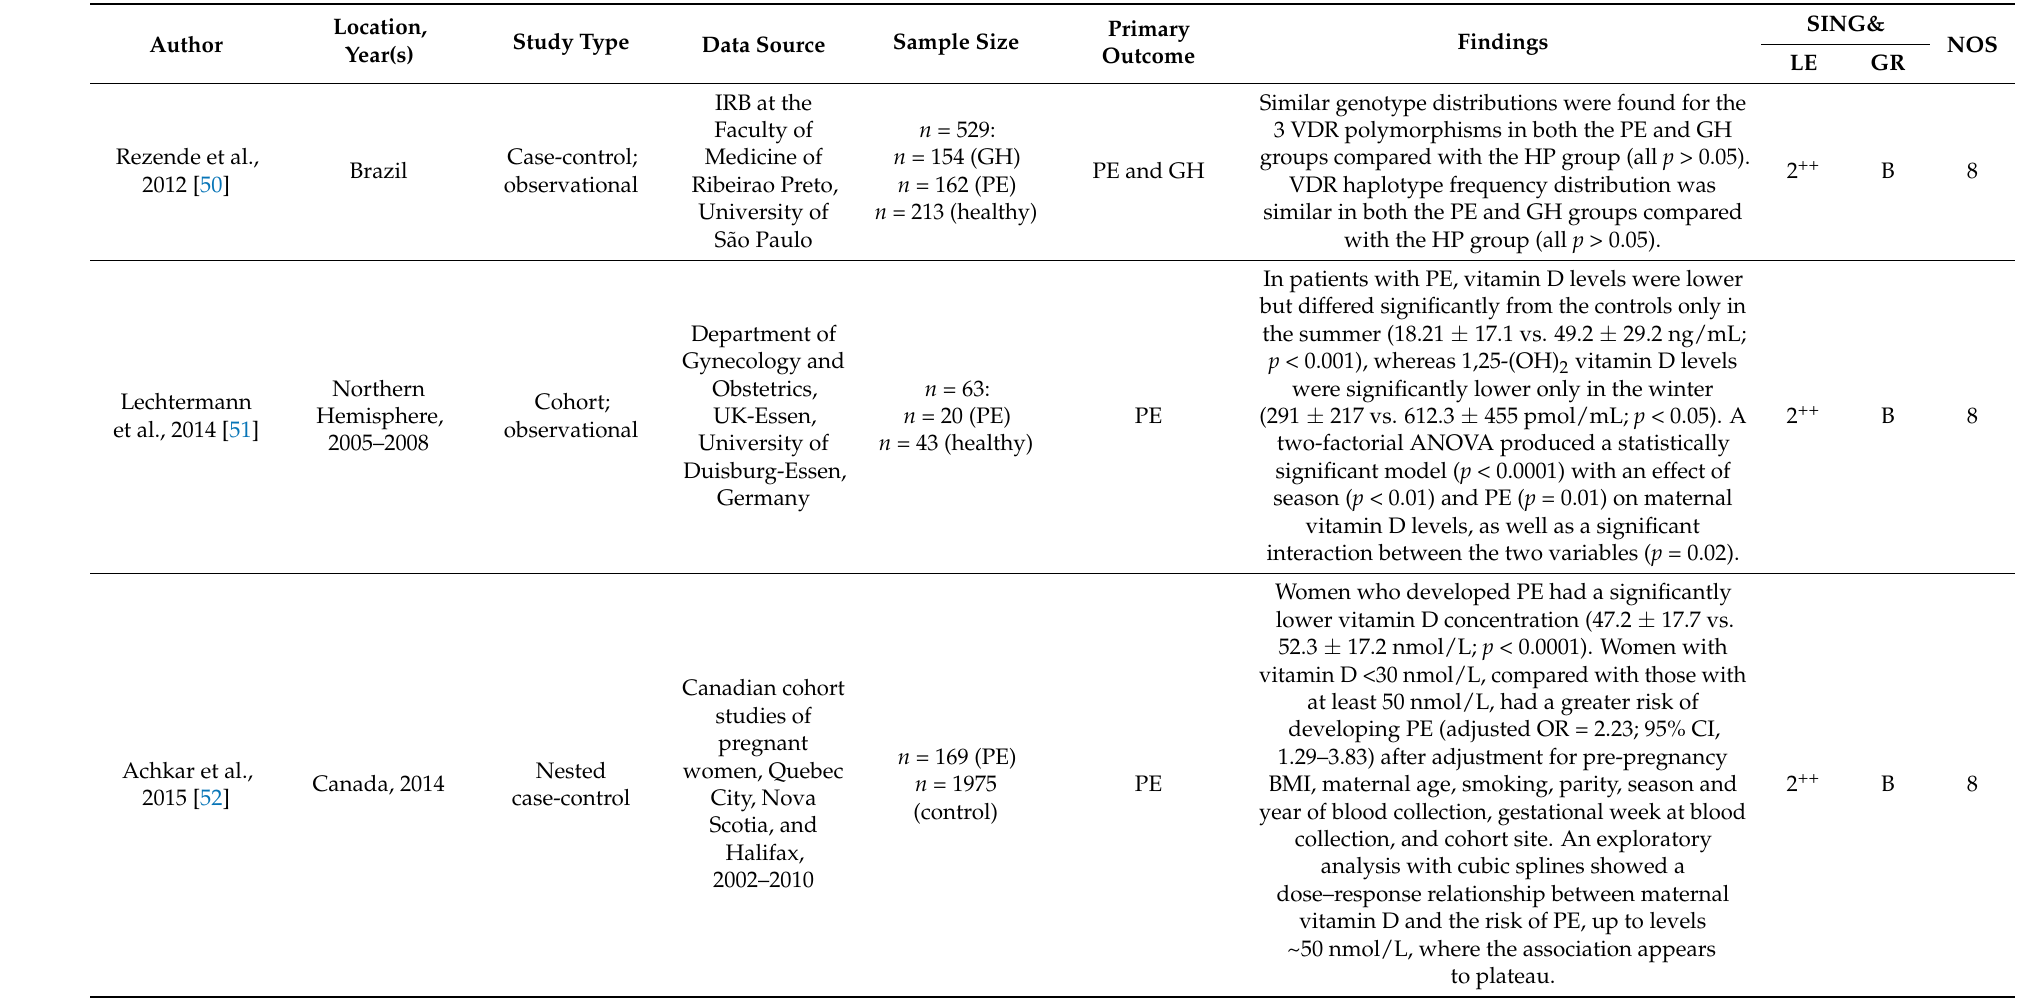
Table 1. Original studies that show vitamin D-related risk factors for maternal morbidity during